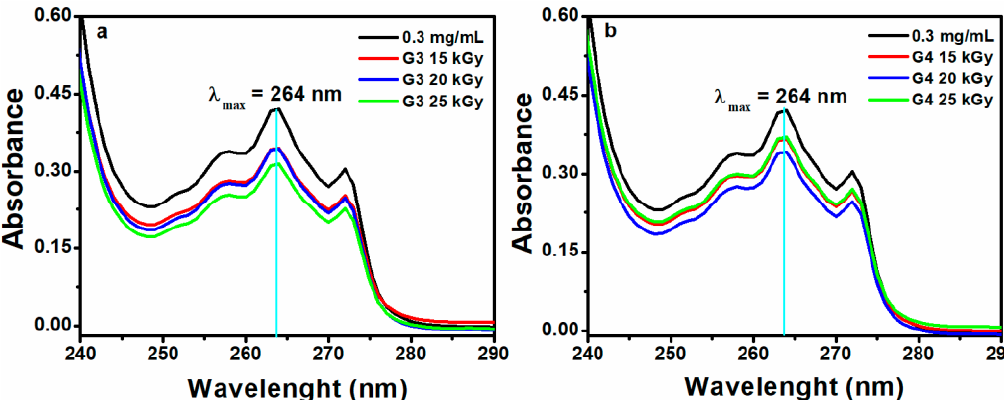
Figure 10. UV-Vis absorption spectra of IBU in ( a ) G3 and ( b ) G4 hydrogels (0.3 mg / mL–UV-Vis spectra for the control sample without